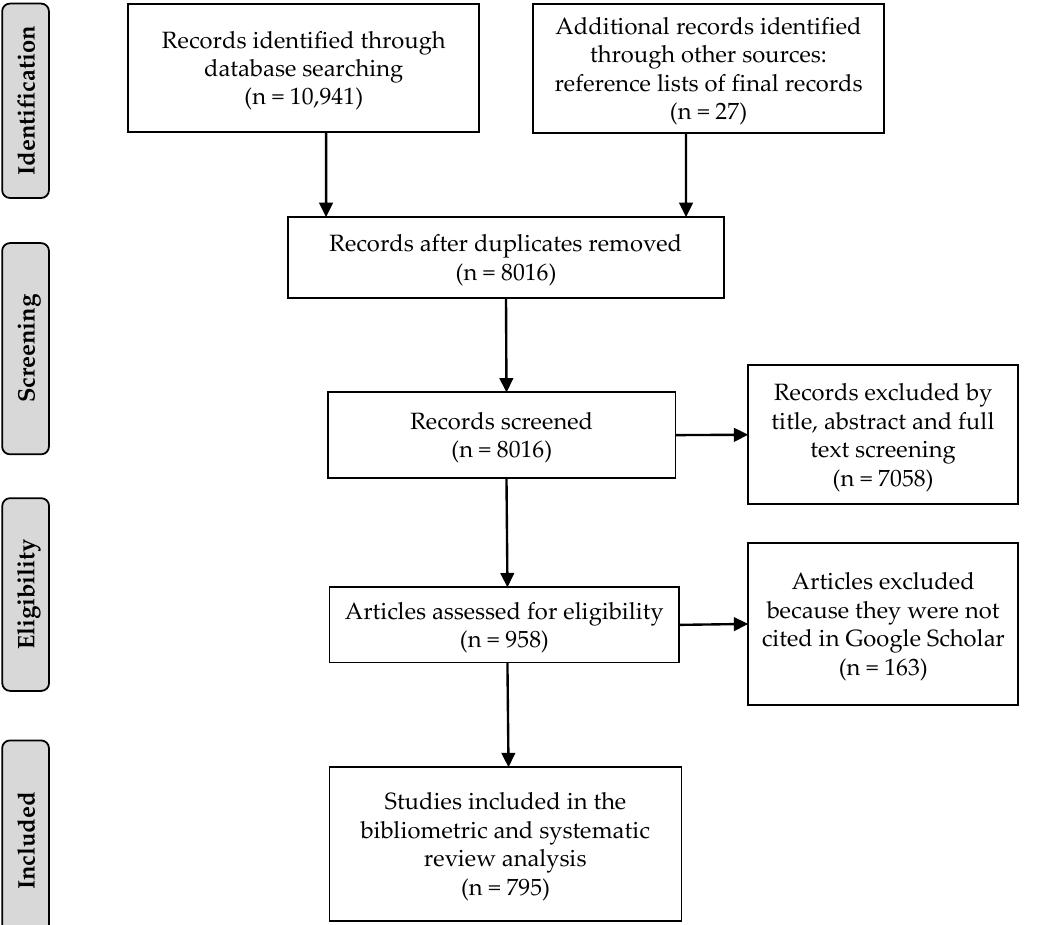
Figure 1. Flow diagram of the study selection process. Source: PRISMA Model [34].